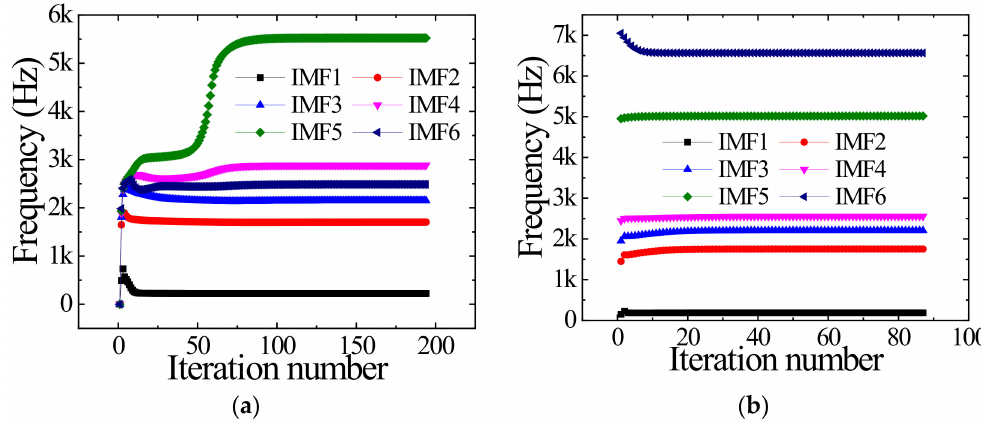
Figure 7. Center frequency iterative curves for IMFs. ( a ) Iterative curves of VMD. ( b ) Iterative curves of